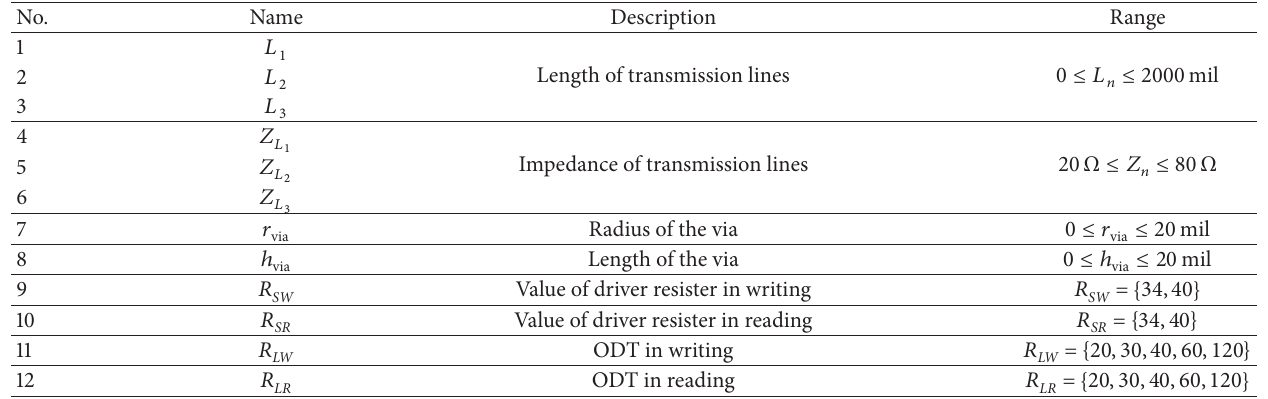
Table 1: The parameters in the fitness